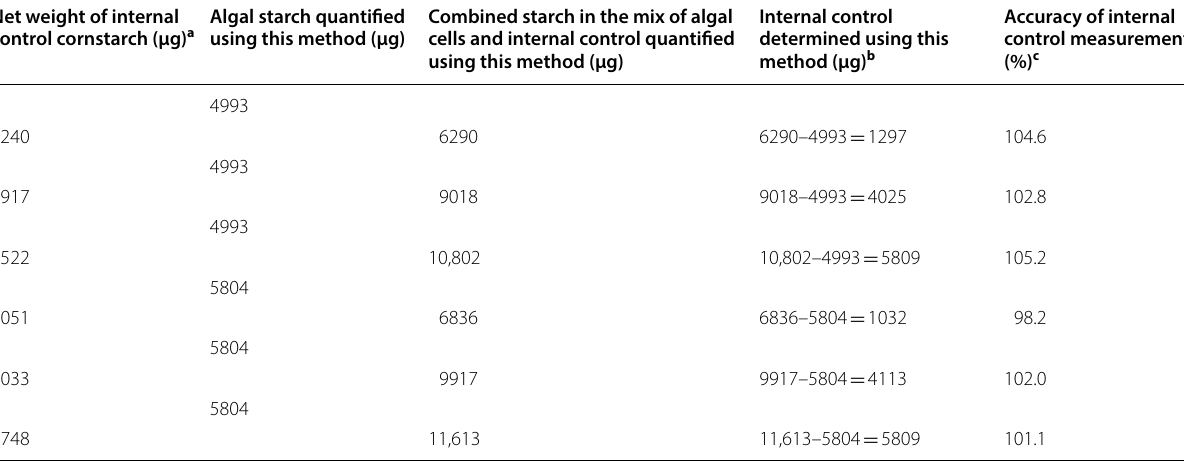
a The net weight excluded the weight of the water, protein and fiber in the cornstarch b The quantities were obtained by subtracting the amount of algal starch measured in the controls (without the cornstarch internal control) from the total starch c Mean SD is 102.3 2.5% (n 6) ± ± =